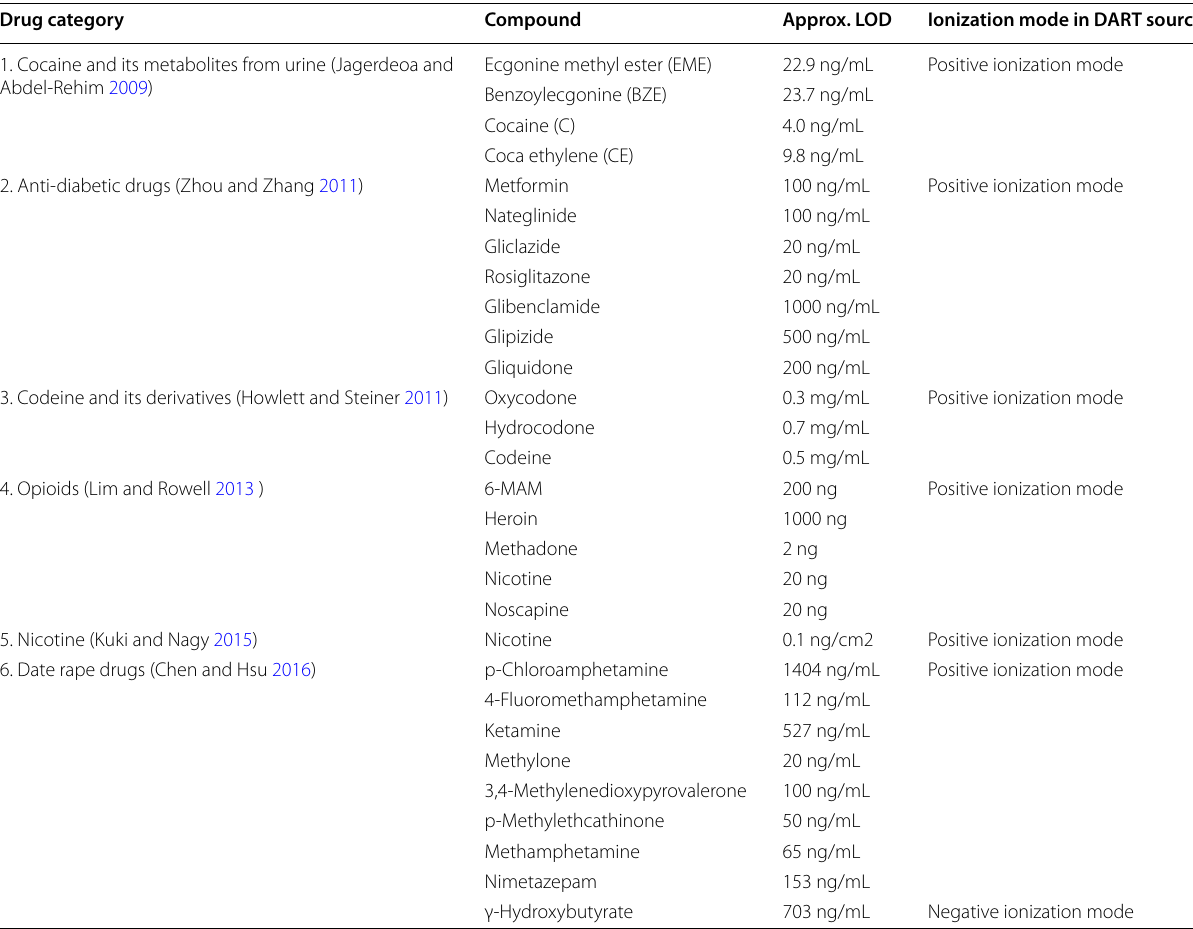
Table 5 Experimentally found LOD for various drug samples spiked with methanol in different